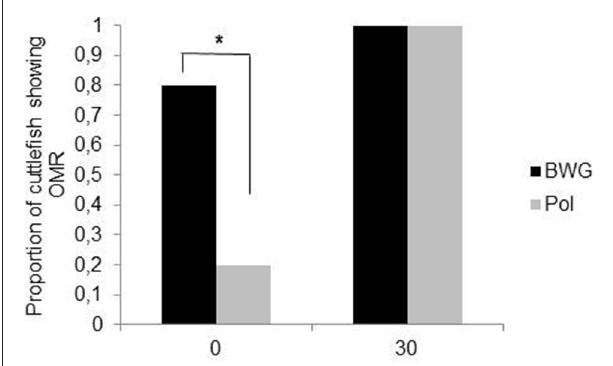
FIGURE 4 | Proportion of the cuttlefish ( N = 10 per group) that showed an optomotor response (OMR) to BWG (luminance only; black) or Pol (polarization; gray) patterns rotating at a velocity of 30 deg s − 1 , at hatching (0) and at the age of 30 days. Asterisks indicate a significant difference in the percentage of cuttlefish showing an OMR between the BWG and Pol patterns McNemar’s test, ( P < 0.05). Modified from Cartron et al.